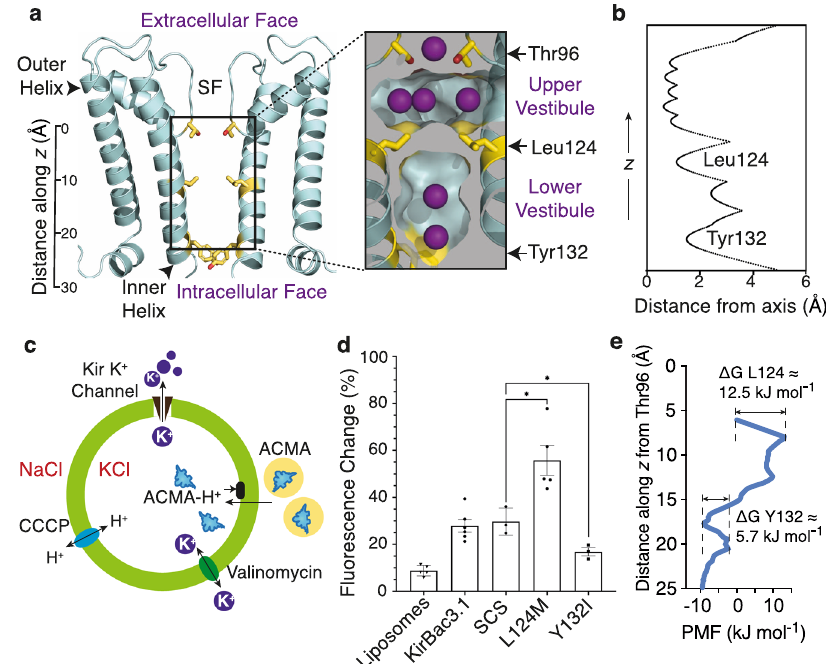
Fig. 1 Branched aliphatic side chains form a barrier to ions within the conduction pathway. a Ribbon representation of the KirBac3.1 pore (cyan); for clarity, only two subunits are shown. The side chains of Leu124, Tyr132 and Thr96 are depicted (yellow sticks). A scale bar indicates the distance (Å) from the centre of mass of Thr96. SF indicates the location of the selectivity fi lter. Insert shows a longitudinal section depicting the accessible surface of the pore interior, highlighting the steric barrier provided by the Leu124 cluster. Potassium ions at binding sites are depicted in purple. b Pro fi le of the pore radius through the transmembrane domain of KirBac3.1 calculated using HOLE 56 . Distances are relative to the molecular axis. c Schematic of the ACMA assay. A lipid-soluble proton-sensitive dye (ACMA) is equilibrated with proteoliposomes (green circle) in isotonic solution (K + in /Na + out ), prior to addition of the protonophore, carbonyl cyanide m-chlorophenyl hydrazone (CCCP). Protons moving into the liposome via CCCP bind ACMA to form ACMA-H + , which does not fl uoresce, resulting in a decrease in total fl uorescence emission. Proton in fl ux is balanced by K + ef fl ux through Kir. Protonated ACMA cannot pass out through the membrane. Limiting fl uorescence is determined by addition of the speci fi c K + ionophore valinomycin. The total fl uorescence change measured in the assay is summed from individual proteoliposomes. d Summary functional assay data for the Leu124M ( n = 5 independent samples) and Tyr132I ( n = 3) point mutants represented as mean ± SEM. Values of n for control samples are 5, 6 and 3 for liposome-only, KirBac3.1 and KirBac3.1-SCS samples respectively. Data analysis was by two-sided t-test analysis of variance and refers to pairwise comparisons to KirBac3.1-SCS as indicated (ns = non-signi fi cant; * p ≤ 0.05). Comparative p-values for KirBac3.1-SCS to Y132I and L124M are 0.265 and 0.249, respectively. Dunnett ’ s test was applied to adjust for multiple comparisons to each control. e PMF along the molecular axis, oriented to match the inset in ( a ). Distances along z are relative to the centre of mass of the four Thr96 sidechains. Source data are provided as a Source data fi